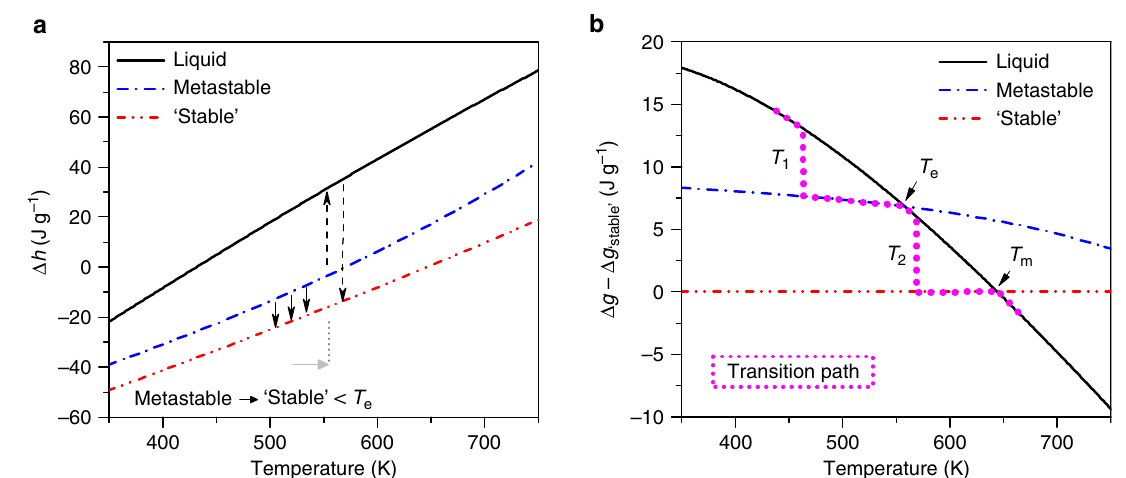
Figure 4 | Thermodynamics of Au 70 Cu 5.5 Ag 7.5 Si 17 . ( a ) Specific enthalpies of the liquid, metastable crystalline state and ‘stable’ crystalline state. The enthalpy changes due to transitions from the metastable to the ‘stable’ state, including the formation of a metastable liquid, are shown by arrows. ( b ) Gibbs free energy diagram. The magenta dotted line reveals the transition path supercooled liquid - metastable crystalline state - metastable liquid - ‘stable’ crystalline state - equilibrium